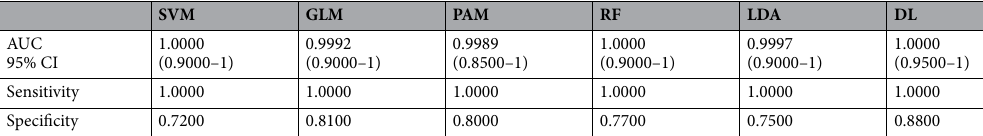
Table 2. Ovarian cancer detection using circulating cfDNA: artificial intelligence with bootstrapping (top 25 variables). Support Vector Machine (SVM), Generalized Linear Model (GLM), Prediction Analysis for Microarrays (PAM), Random Forest (RF), Linear Discriminant Analysis (LDA) and Deep Learning (DL). Important predictors in order: SVM: cg22563825, cg16474643, cg05476766, cg20675030,